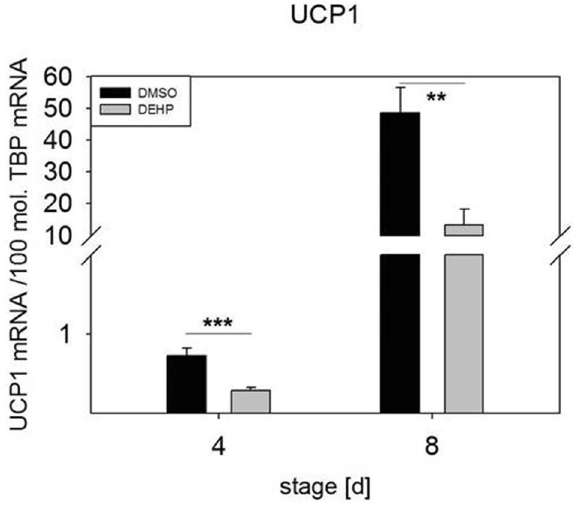
Figure 4. mRNA expression of UCP1 in SGBS-derived cells. SGBS-derived cells were exposed to DEHP [50 µg/ml] from d0–d4 of adipogenesis. For qRT-PCR, mRNA samples of (pre)adipocytes were taken at d4 and d8 of differentiation. The TATA-Box binding protein (TBP) was used as a housekeeping gene. The data were statistically analyzed by one-way ANOVA. N = 8, n = 1 (4 pooled wells); *p ≤ 0.05; **p ≤ 0.01, ***p ≤ 0.001.